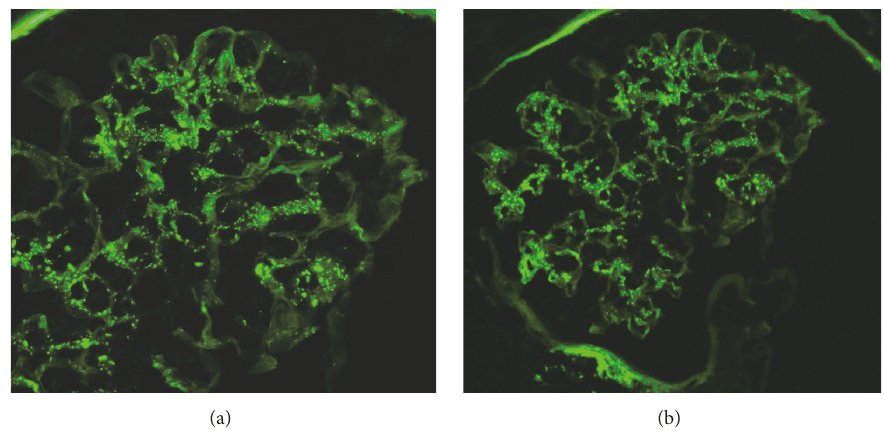
Figure 2: Immunofluorescence positive for C3 (a) and IgM (b) deposition in the mesangium.